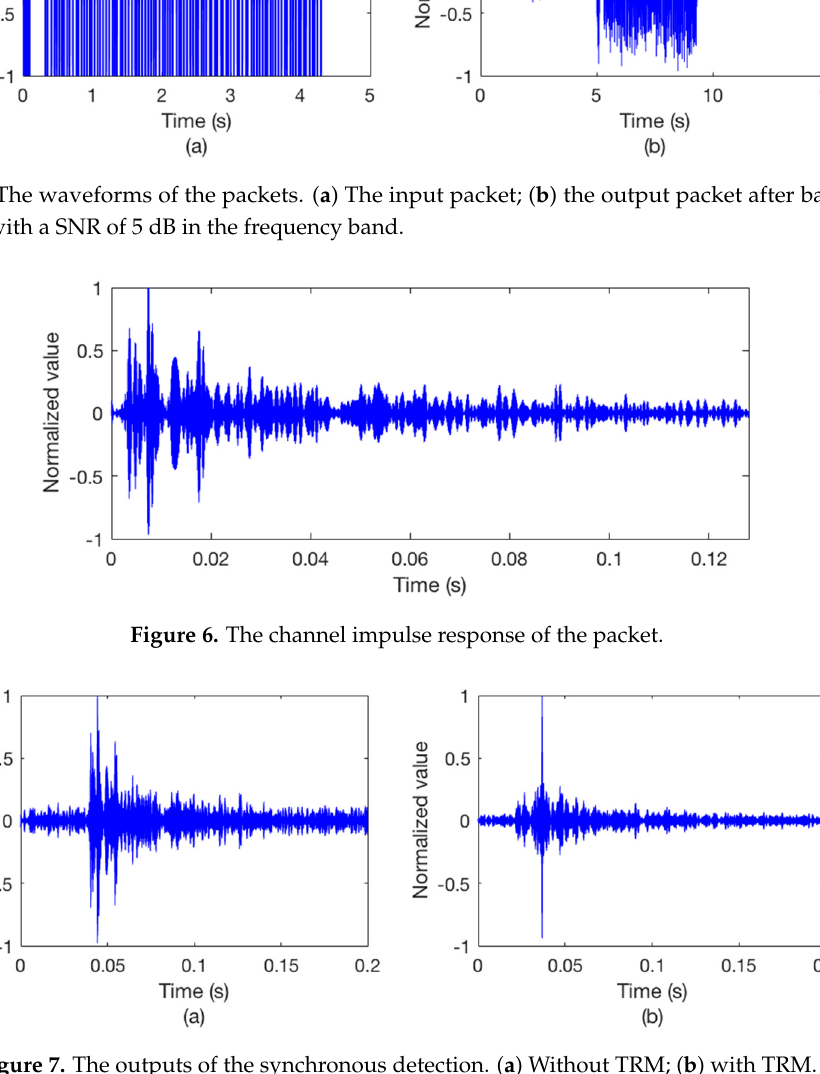
Figure 7. The outputs of the synchronous detection. (a) Without TRM; (b) with TRM.